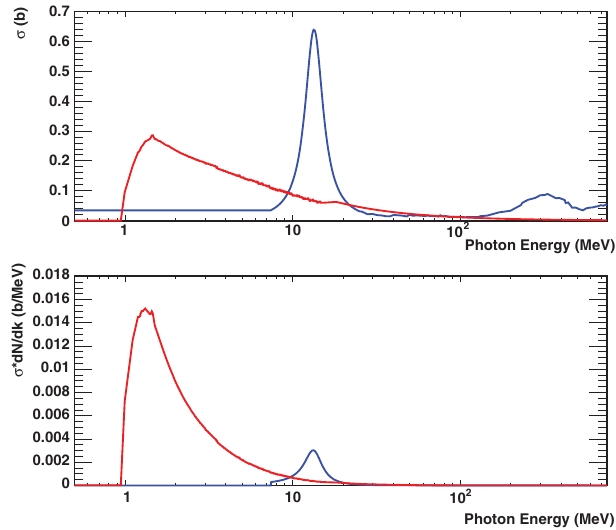
FIG. 1. (Top) Per-photon cross section for bound-free (blue line) and Coulomb excitation (red line) for gold beams at eRHIC, as a function of photon energy, in the target rest frame. (Bottom) Flux-weighted cross sections for eA production of Coulomb excited gold and BFPP. The photon spectrum scales as 1 =k , so the reactions are concentrated at low photon energies.